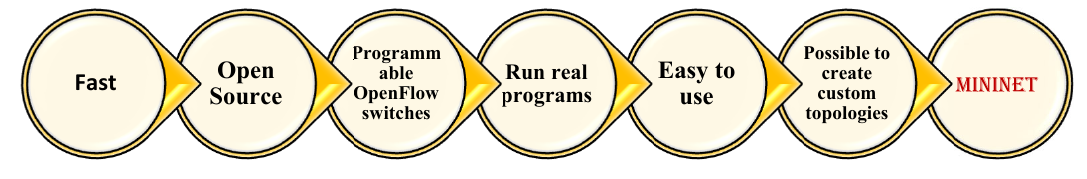
Figure 12. Mininet Features.